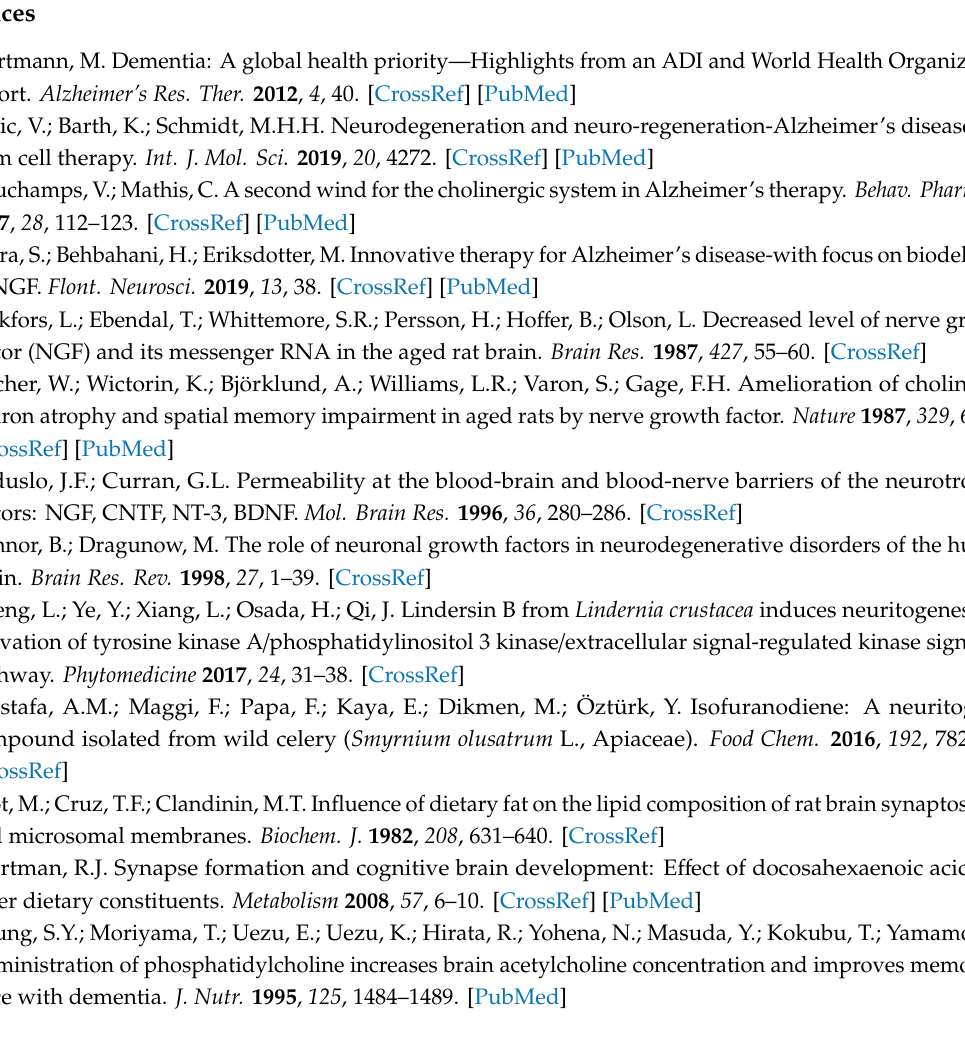
Supplementary Materials: Figure S1: Neurite outgrowth-promoting activity of sunflower seed extract in the presence of NGF in PC12 cells. Figure S2: Neurite outgrowth-promoting activity of sunflower seed extract in the presence of Bt 2 cAMP in PC12